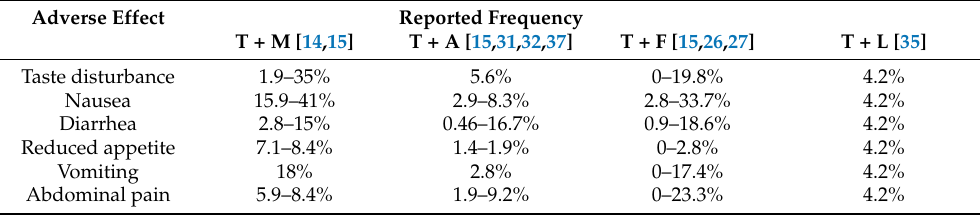
Table 3. Adverse events of tetracycline-containing bismuth quadruple eradication